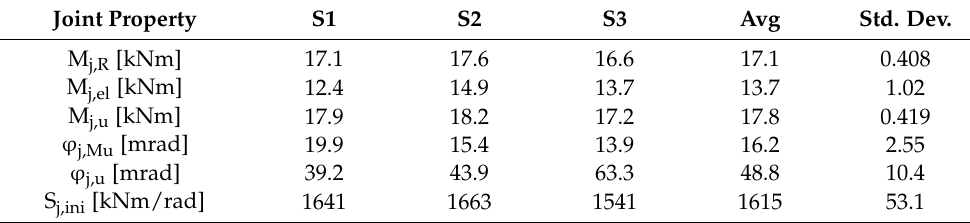
Table 2. Main properties of the M j – φ j curves.